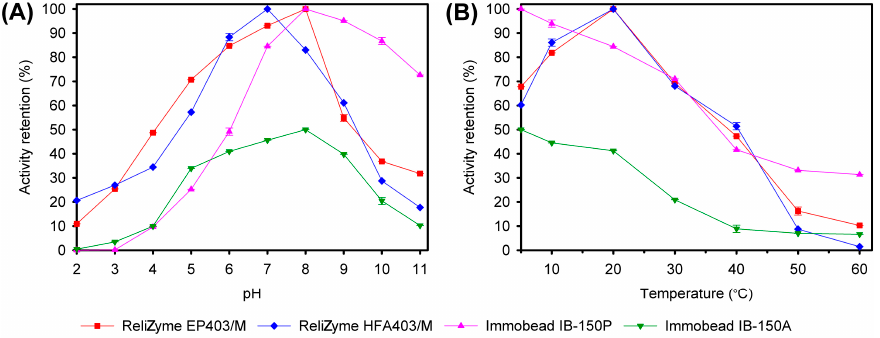
Figure 2. Optimization of TASKA immobilization conditions on 4 different supports. ( A ) Effects of pH on TASKA immobilization; ( B ) Effects of temperature on TASKA immobilization. The values shown represent the mean ± standard error of triplicate analyses.